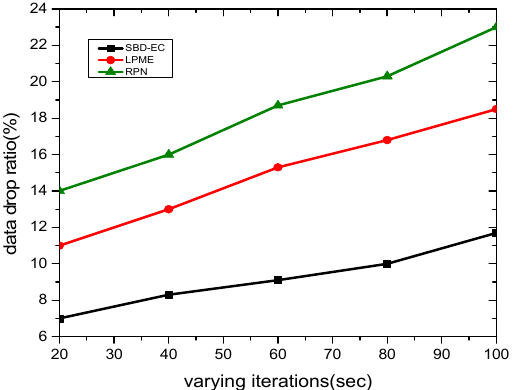
Figure 5. Data drop ratio and iterations.